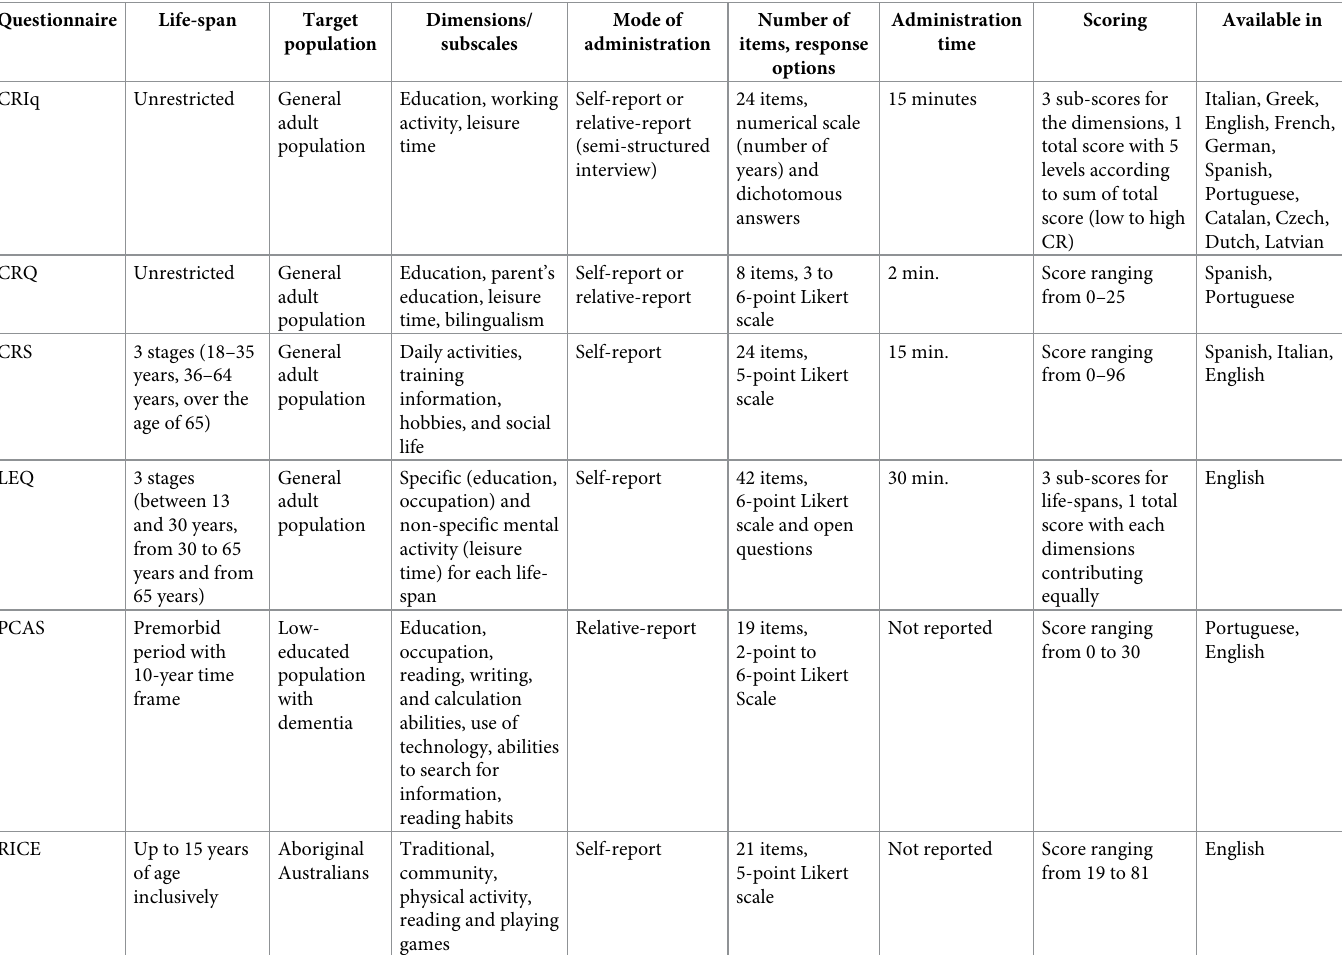
Table 3. General characteristics of the studied CR questionnaires. CRIq = Cognitive Reserve Index Questionnaire, CRQ = Cognitive Reserve Questionnaire, CRS = Cognitive Reserve Scale, LEQ = Lifetime of Experience Questionnaire, RICE = Retrospective Indigenous Childhood Enrichment scale, PCAS = Premorbid Cogni- tive Abilities